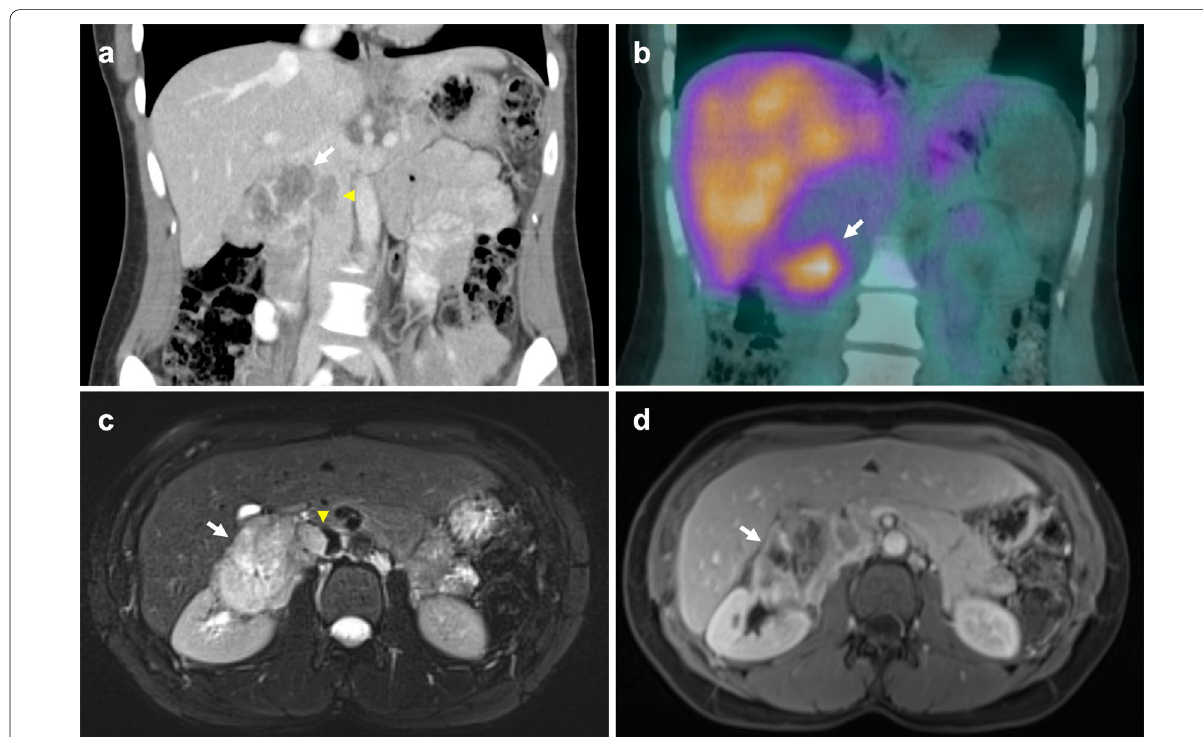
Fig. 20 Malignant extra-adrenal phaeochromocytoma invading IVC. a Coronal portal venous phase CT shows a heterogeneously enhancing peri-renal mass (arrow) with possible central necrosis that abuts and extends into the infrarenal IVC (arrowhead). b SPECT CT demonstrates a focus of abnormal MIBG uptake (arrow) within the region of the peri-renal mass. Selected MR images show the retroperitoneal lesion ( c ) partially obstructing the IVC (arrowhead), demonstrating heterogeneous elevated T2 signal (arrow) on the selected T2-weighted fat-saturated axial image and ( d ) heterogeneous enhancement (arrow) on the selected T1-weighted fat-saturated axial